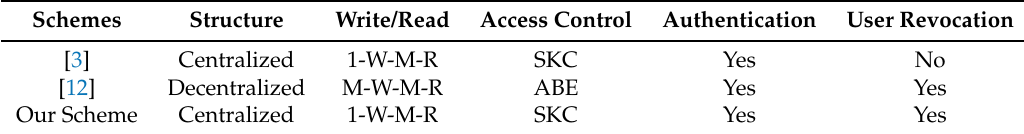
Table 3. Comparison of Our Scheme with Other Existing Secure Schemes.